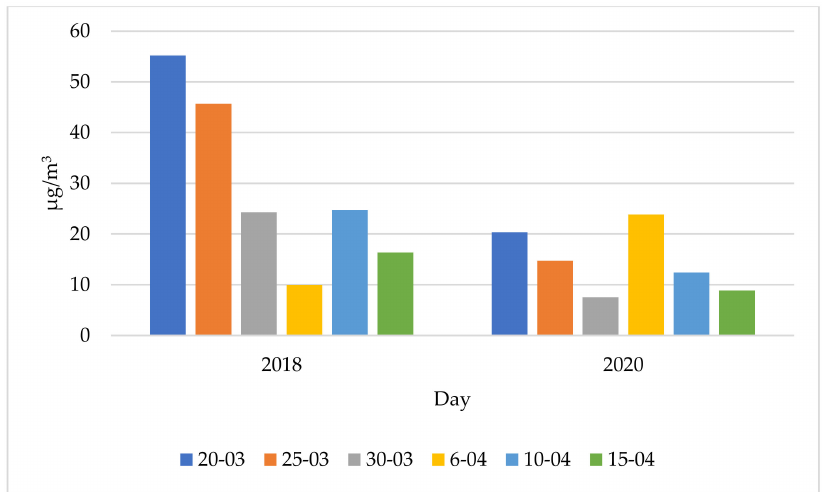
Figure 15. SO 2 concentration in Warsaw on individual days of 2018 and 2020. Source: Own elabora- tion, based on data from Copernicus Atmosphere Monitoring Service (CAMS)